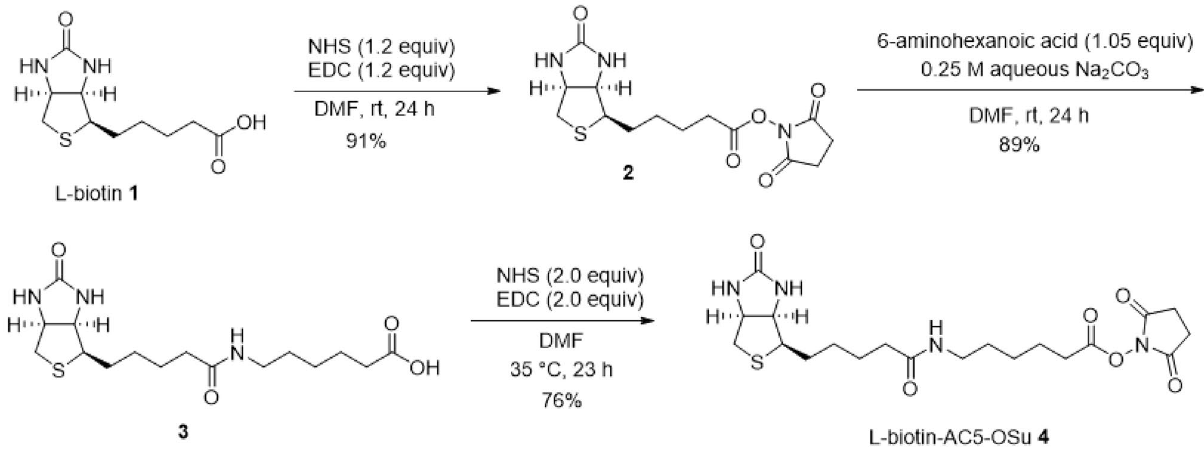
Figure 1. Synthesis of L-biotin-AC5-OSu. PerkinElmer, ChemDraw professional version 17.1.0.105(19) (https:// perki nelme rinfo rmati cs. com/ produ cts/ resea rch/ chemd raw/).